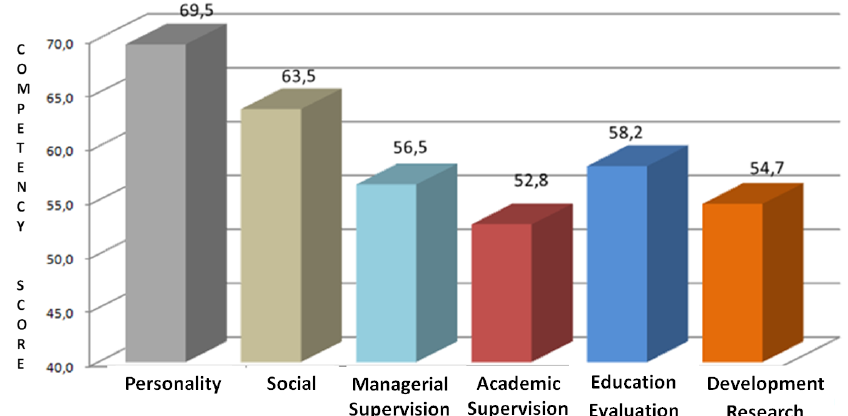
Figure 1. Mastery of School Supervisor Competencies (Source: Directorate of Education Personnel